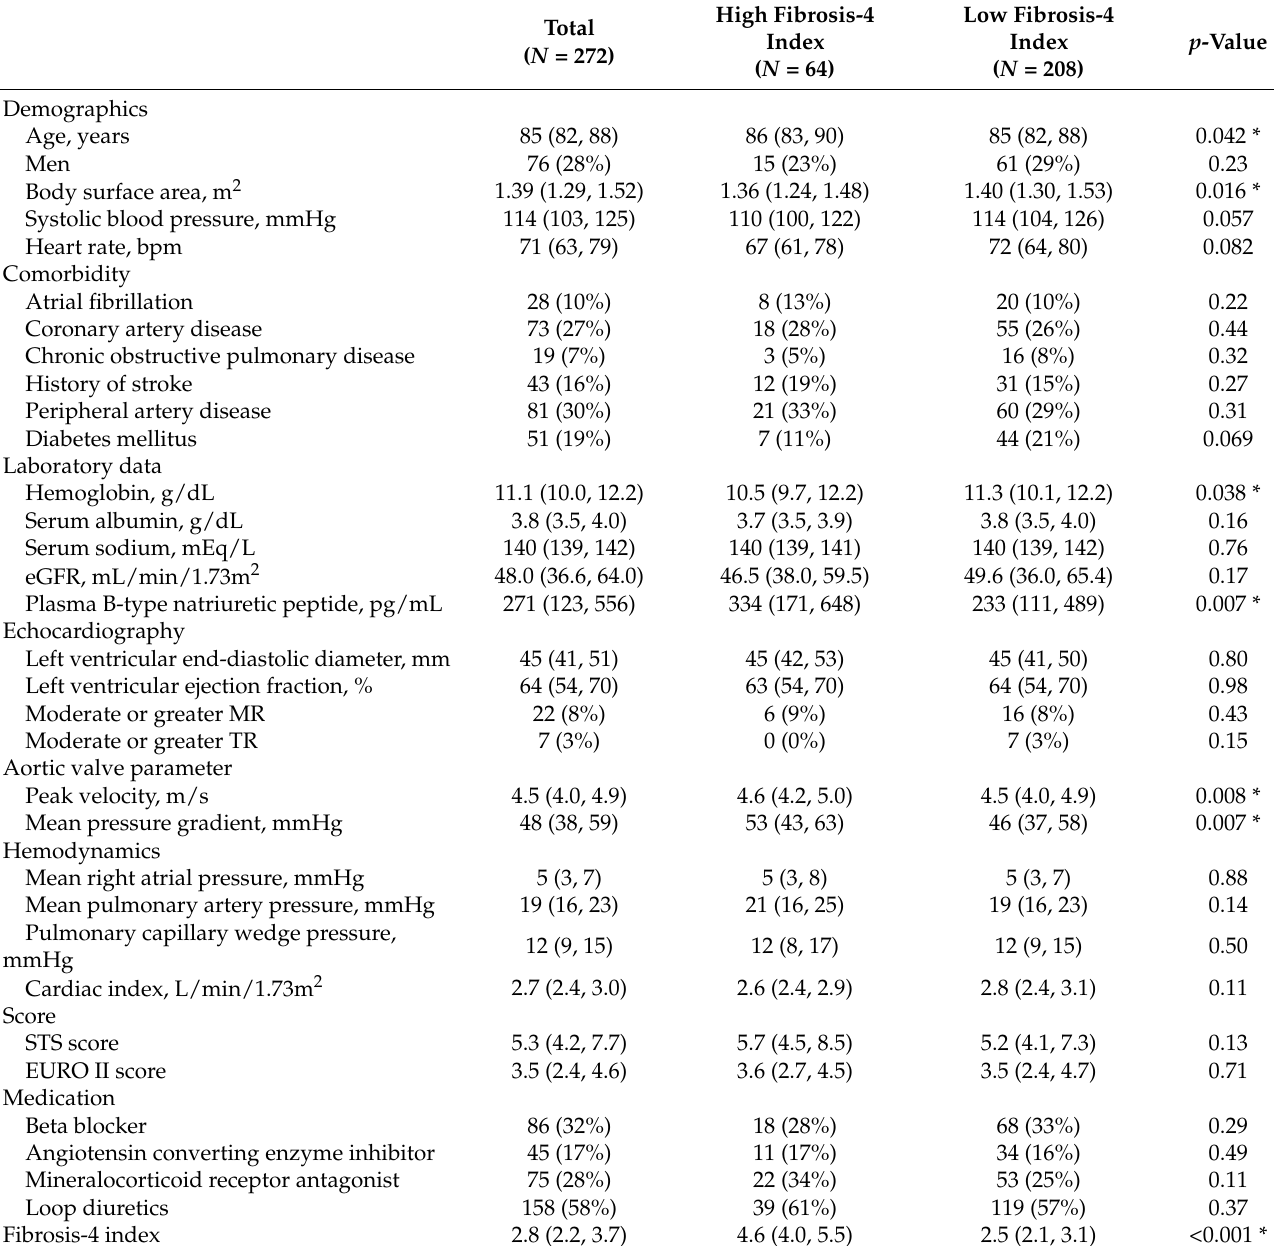
Table 1. Pre-procedural baseline